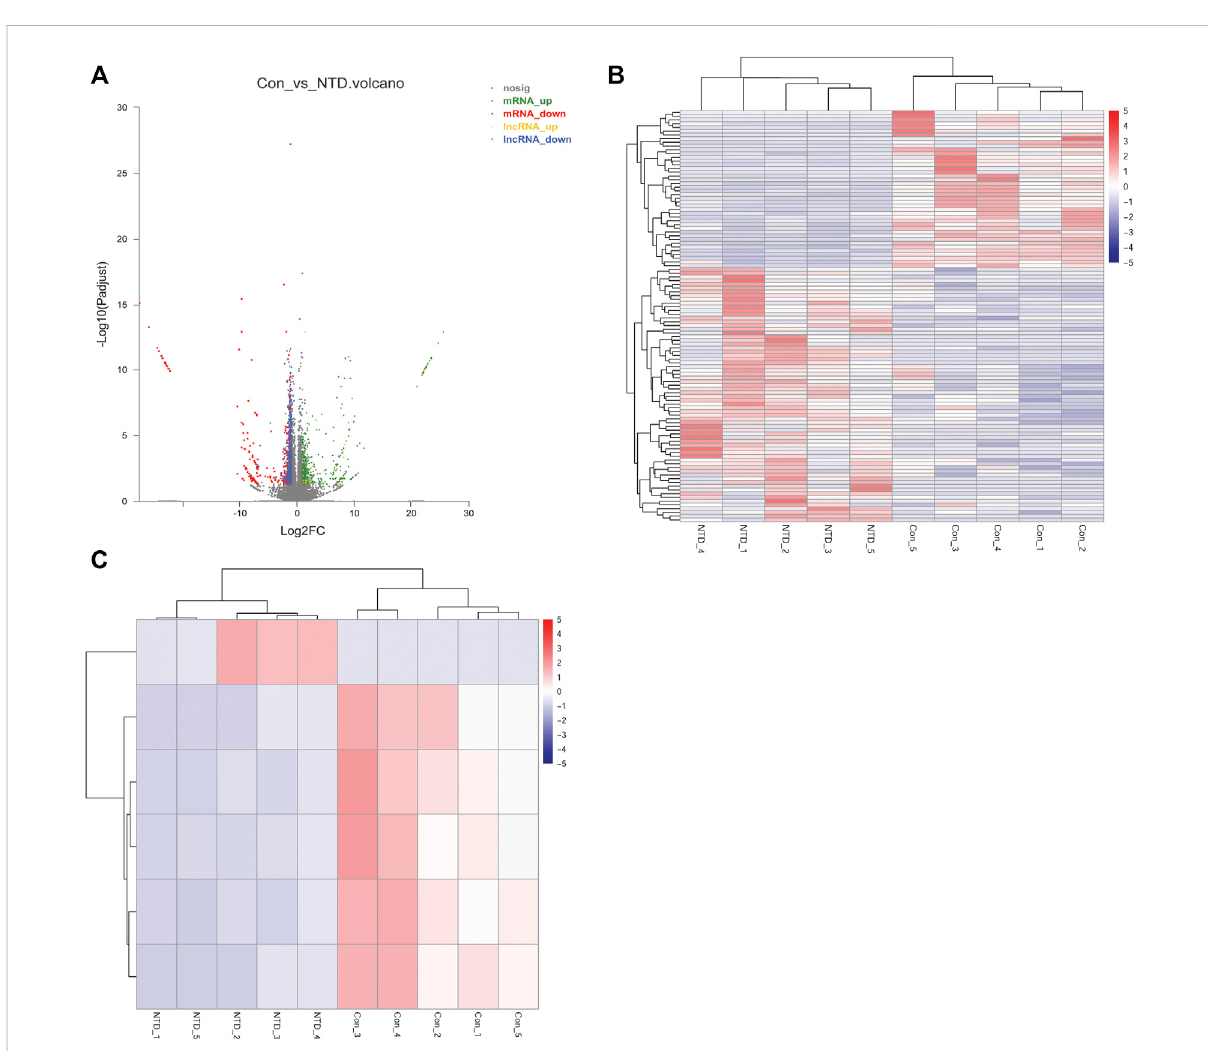
FIGURE 3 Analysis of DElncRNAs and DEGs between the NTD and control groups based on RNA-seq data. (A) Volcano plot of DElncRNAs and DEGs. Green, red, yellow, and blue nodes represent upregulated mRNAs, downregulated mRNAs, upregulated lncRNAs, and downregulated lncRNAs, respectively. (B) Heat map of DElncRNAs. (C) Heat map of